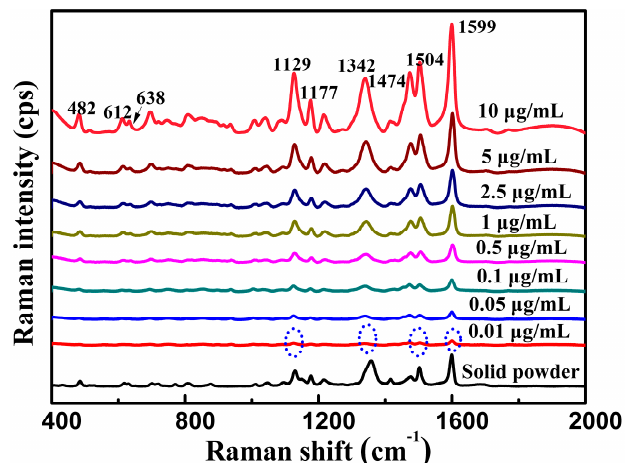
Figure 3. Surface-enhanced Raman scattering (SERS) optical spectra of the standard tartrazine solution ( n = 40).